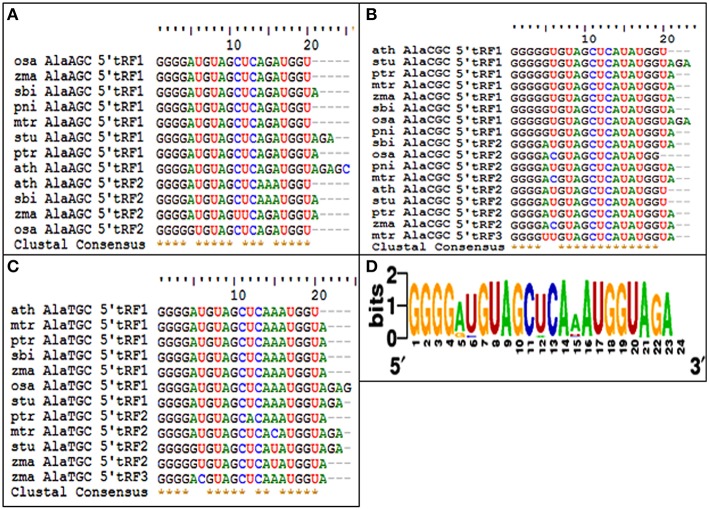
The conservation of 5′tRFs from Alanine tRNAs among the angiosperm plants. Sequence alignments of (A) 5′AlaAGC tRFs, (B) 5′AlaCGC tRFs, and (C) 5′AlaTCG tRFs. (D) Multiple alignments of all the 5′AlatRFs were represented as sequence logo. ath, A. thaliana; mtr, M. truncatula; zma, Z. mays; ptr, P. trichocarpa; osa, O. sativa; sbi, S. bicolor; stu, S. tuberosum; and pni, P. nigrum.